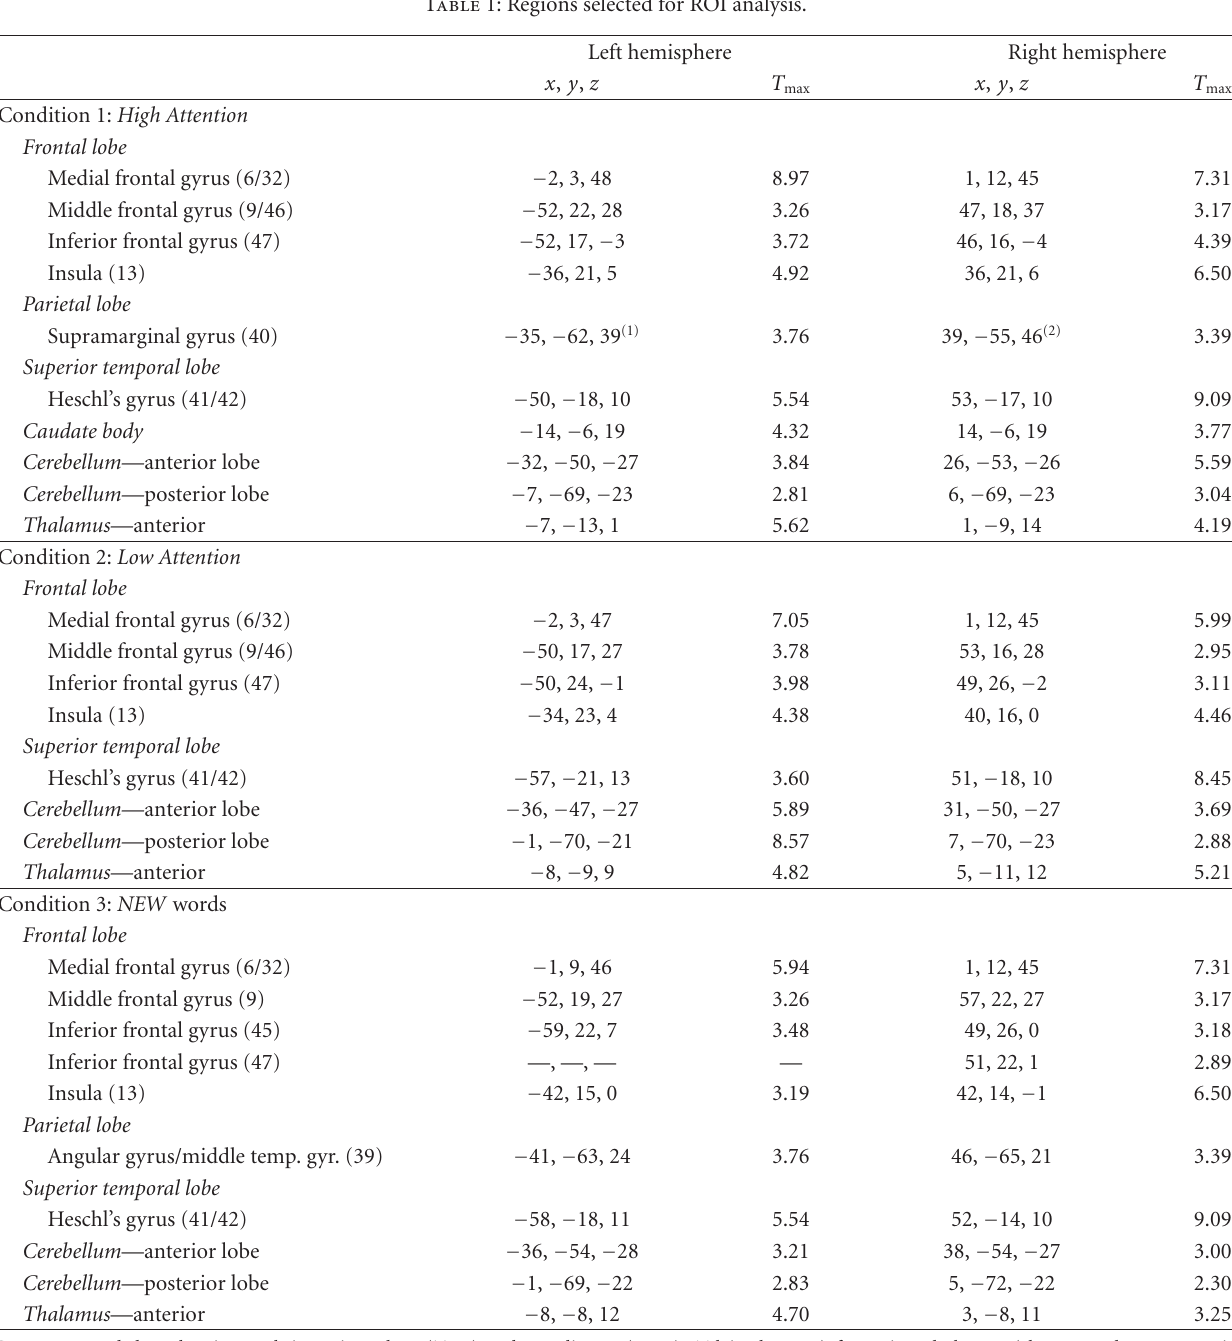
Table 1: Regions selected for ROI